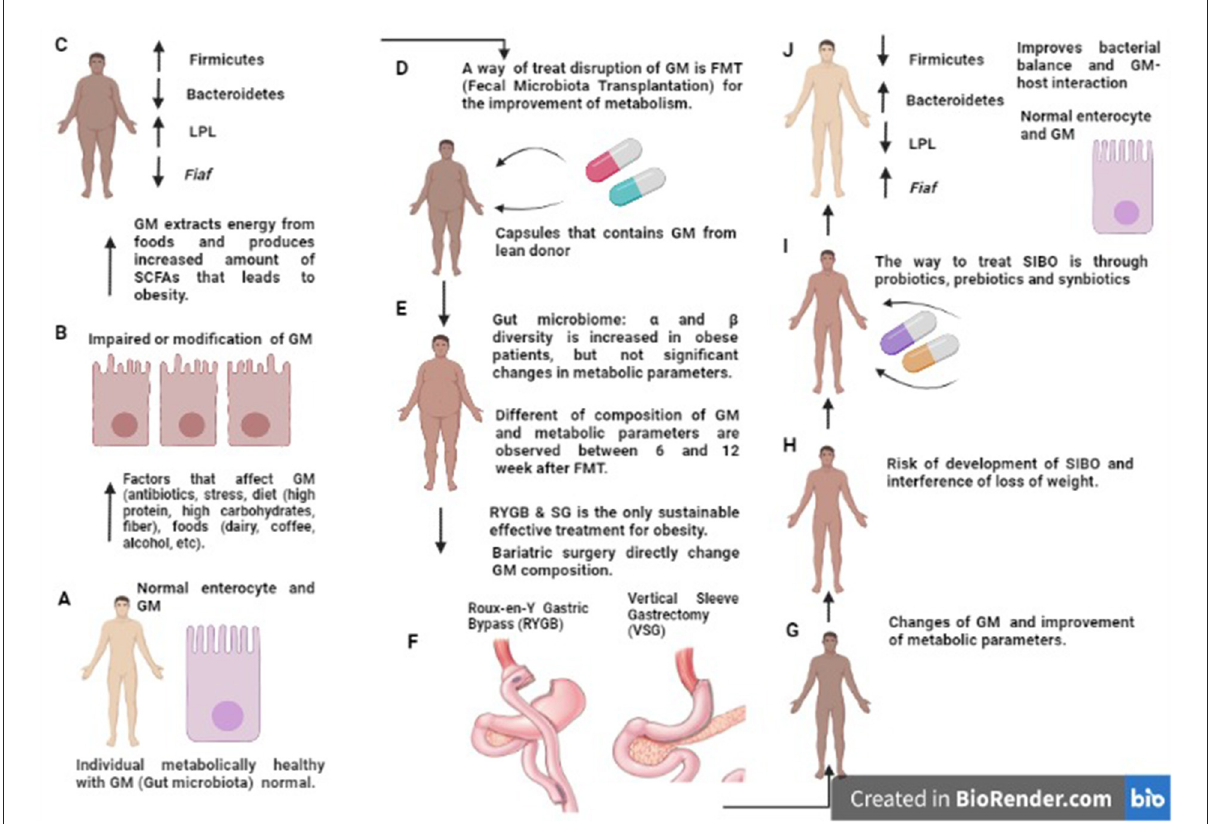
FIGURE3 Disruption in intestinal microbiota composition and treatment by FMT, BS, probiotics, prebiotics and synbiotics. Schematic representation of altered GM composition in obesity and MS. In people metabolically healthy, the GM and enterocyte are normal (A) . In obesity, altered GM composition (diet, drugs, stress, etc.) inhibits Fiaf in epithelial cells and increases LPL activity; this leads to increased synthesis of triglycerides, fatty acids, and fat storage in adipocytes (B,C) ; the opposite effect can be seen after treatment (RYGB, VSG) (D–F) in which the amount of Fiaf inhibits LPL [described in (J) ]. However, there is a risk of SIBO (G,H) . Prebiotics, probiotics, and synbiotics are an alternative to treatment and have been described to achieve a balanced gut microbiota and lead to a healthy metabolic state (I,J) . MS, Metabolic Syndrome; GM, Gut microbiota; Fiaf, Fasting-Induced Adipose Factor or Angptl4; LPL, Lipoprotein lipase; RYGB, Roux-en-Y Gastric Bypass; VSG, Vertical Sleeve Gastrectomy; SIBO, Small Intestinal Bacterial